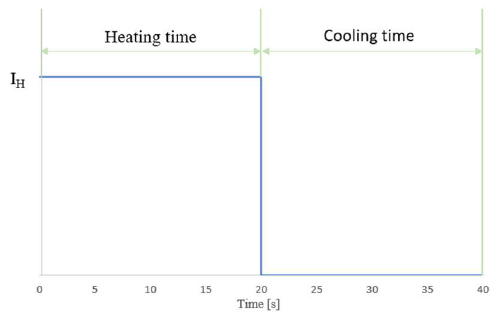
Figure 3. Waveform of the heating current values during the measurement. For each diameter of the tested samples, the values of heating current were different and depended on the nominal current specified by the manufacturer. The nominal current for NiTi wires of a given diameter and the measured current values are shown in Table 2. Table 2. Nominal current values and heating current range for a sample of a given diameter [29]. Diameter ( µ